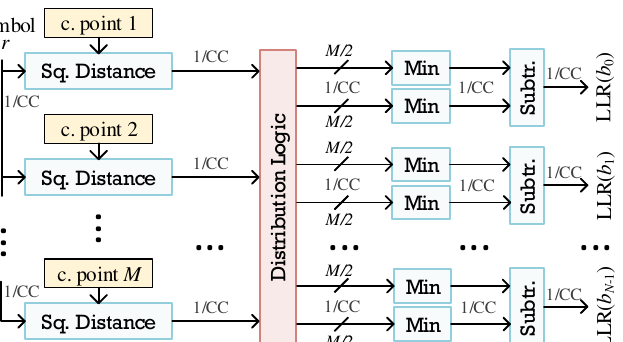
Figure 2. M -QAM demodulation architecture of the approximate log likelihood ratio (ALLR) algo- rithm.